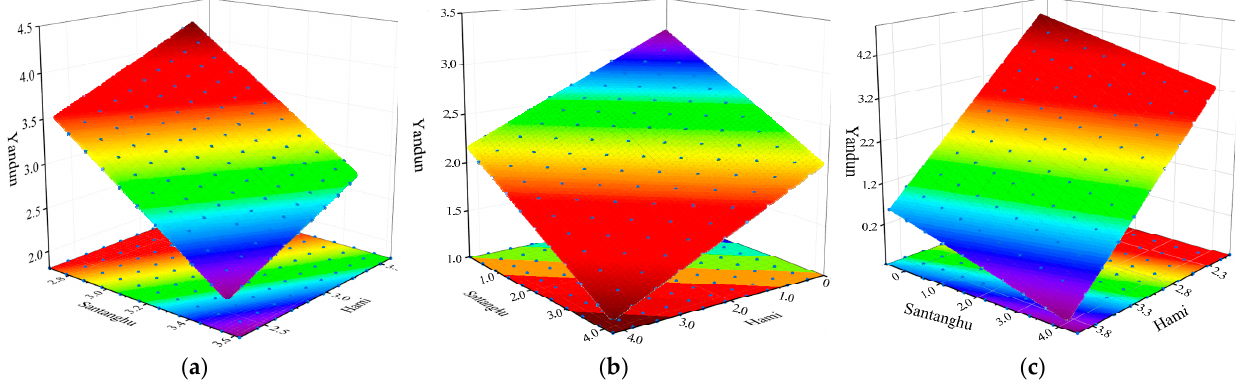
Figure 12. DSSRs of three cases with different power outputs (Case 1: Santanghu station; Case 2: Hami station; Case 3: Yandun station). ( a ) A 40% power output; ( b ) 70% power output; ( c ) ultimate output.